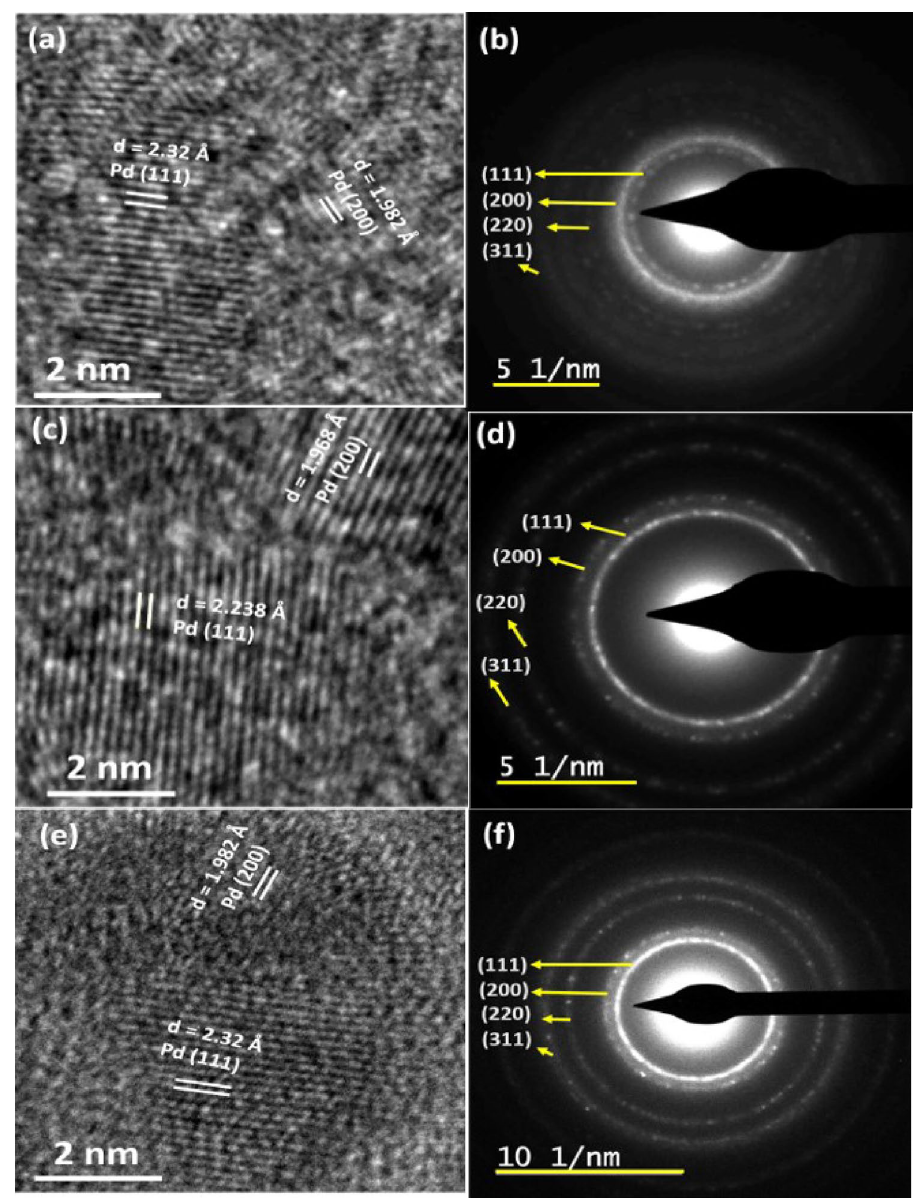
Figure 2. HRTEM micrographs of ( a ) 4.25 nm, ( c ) 4.5 nm and ( e ) 5 nm thin films measured at a 2 nm resolution. Lattice planes have been marked by white lines and distances corresponding to the Pd lattice shown. ( b ), ( d ) and ( f ) represent SAED images corresponding to HRTEM images of ( a ), ( c ) and ( e ) respectively. Lattice planes corresponding to the rings have been marked by arrows and